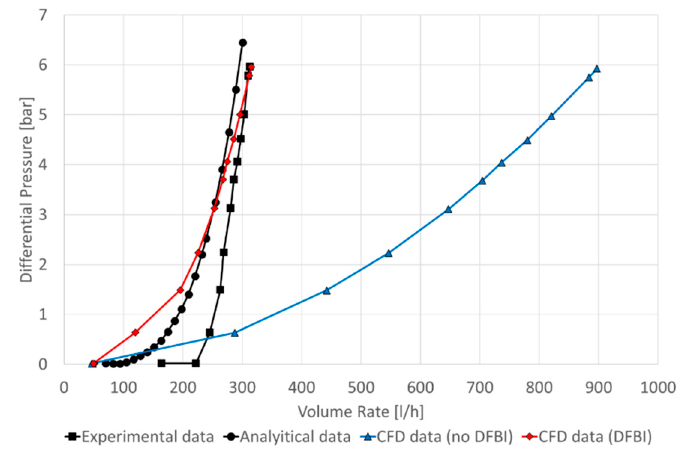
Figure 12. Results of the validation with the simulated, experimental, and analytical data.